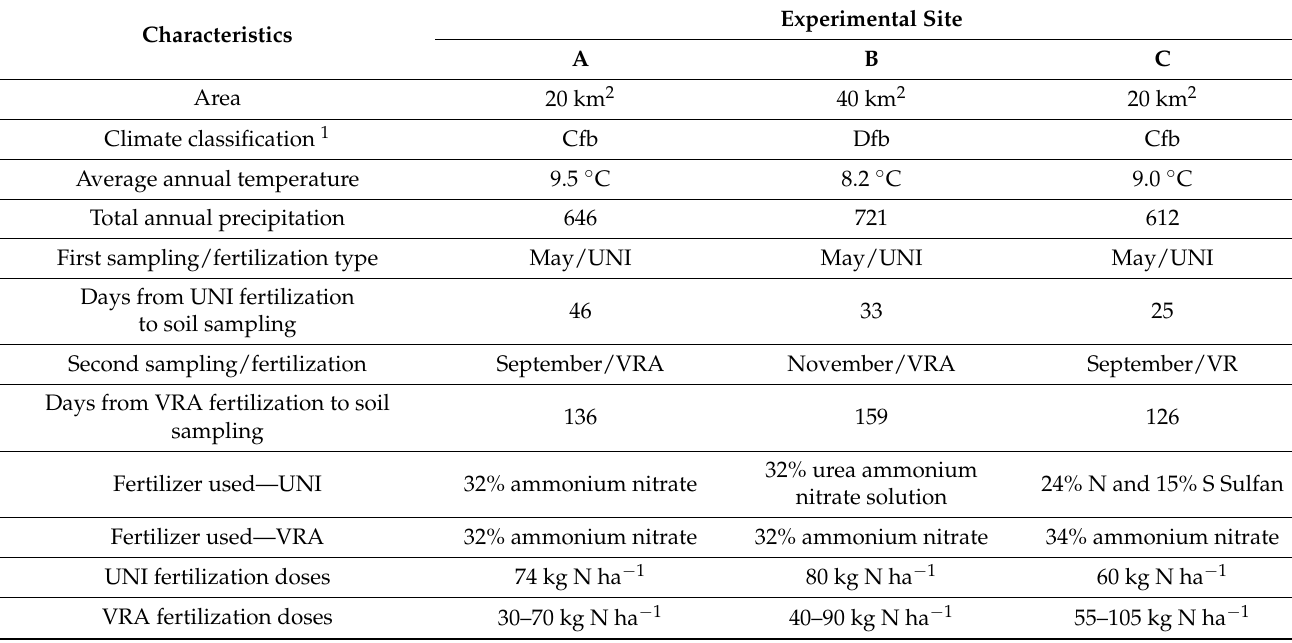
Table 2. Characteristics of the study sites and fertilization.